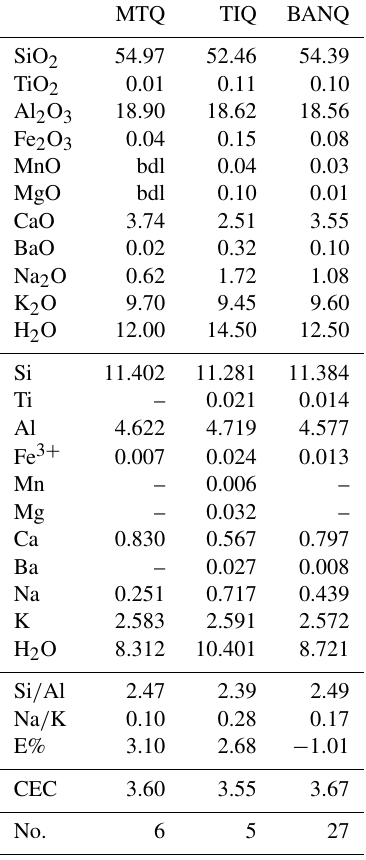
Table 4. Chemical analyses of chabazites. Chemical formula is cal- Table 5. Chemical analyses of phillipsites. Chemical formula culated on the base of 24 O. H 2 O reported on a TG basis. MTQ: is calculated on the basis of 32 O. bdl: below detection Monte Tempio quarry, Sutri; TIQ: Tufitalia quarry, Civita Castel- limit. H 2 O reported on TG basis. MTQ: Monte Tempio quarry, lana; BAN: La Bannita quarry, Castel S. Elia. No.: number of analy- Sutri; TIQ: Tufitalia quarry, Civita Castellana; BAN: La Ban- ses. E% = {(Al + Fe)-[Na + K + 2(Ca + Mg)]}/[Na + K + 2(Ca + Mg)] nita quarry, Castel S. Elia. No.: number of analyses. E% = (Passaglia et al., 1990). CEC: theoretical cation exchange capacity. {(Al + Fe)-[Na + K + 2(Ca + Mg)]}/[Na + K + 2(Ca + Mg)] (Passaglia et al., 1990). CEC: theoretical cation exchange MTQ TIQ BANQ